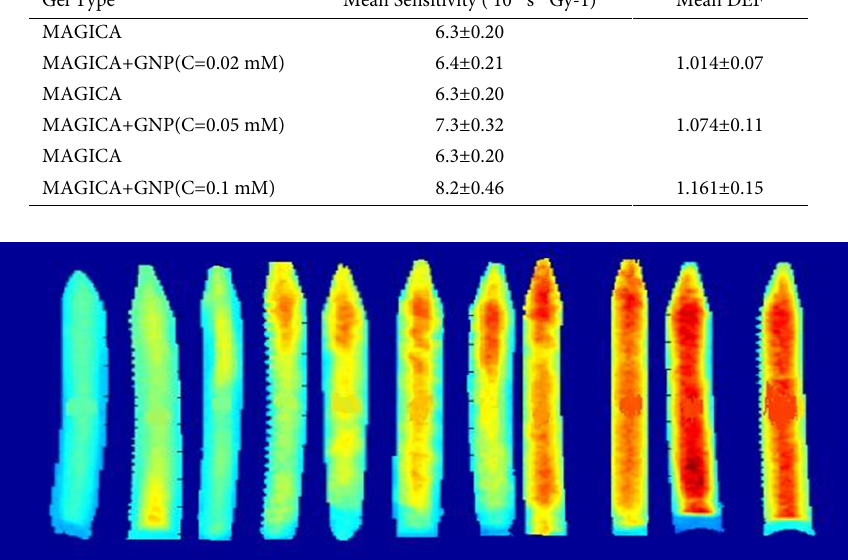
Table 1.The sensitivity and dose enhancement for MAGICA with and without 50 nm GNPs at different concentrations for 18 MV energy Gel Type